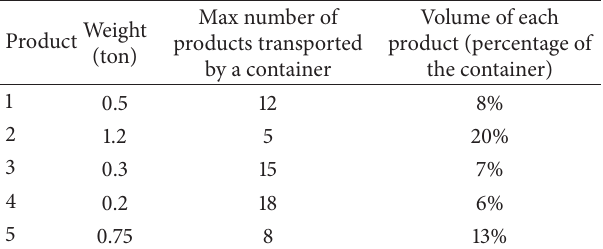
Table 16: Physical features of the demanded